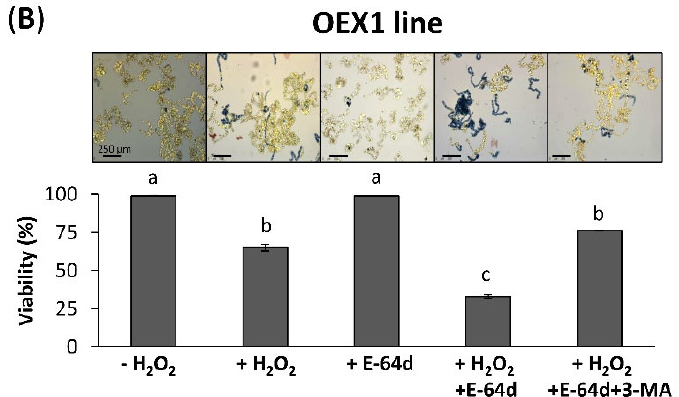
Figure 4. Cell viability of the control ( A ) and Pstrxo1 transformed ( B ) TBY-2 lines 24 h after 35 mM H 2 O 2 treatment in the absence and presence of the autophagy inhibitors E-64d and 3-MA. Cell viability (percentage) without treatment (-) and after treatment (+) with H 2 O 2 , E-64d, H 2 O 2 + E-64d, and H 2 O 2 + E-64d + 3-MA was tested using Trypan Blue dye 24 h after the respective treatments. Values represent mean ± standard error of four independent experiments. Different letters indicate significant differences ( p < 0.05) among treatments according to Tukey’s test.